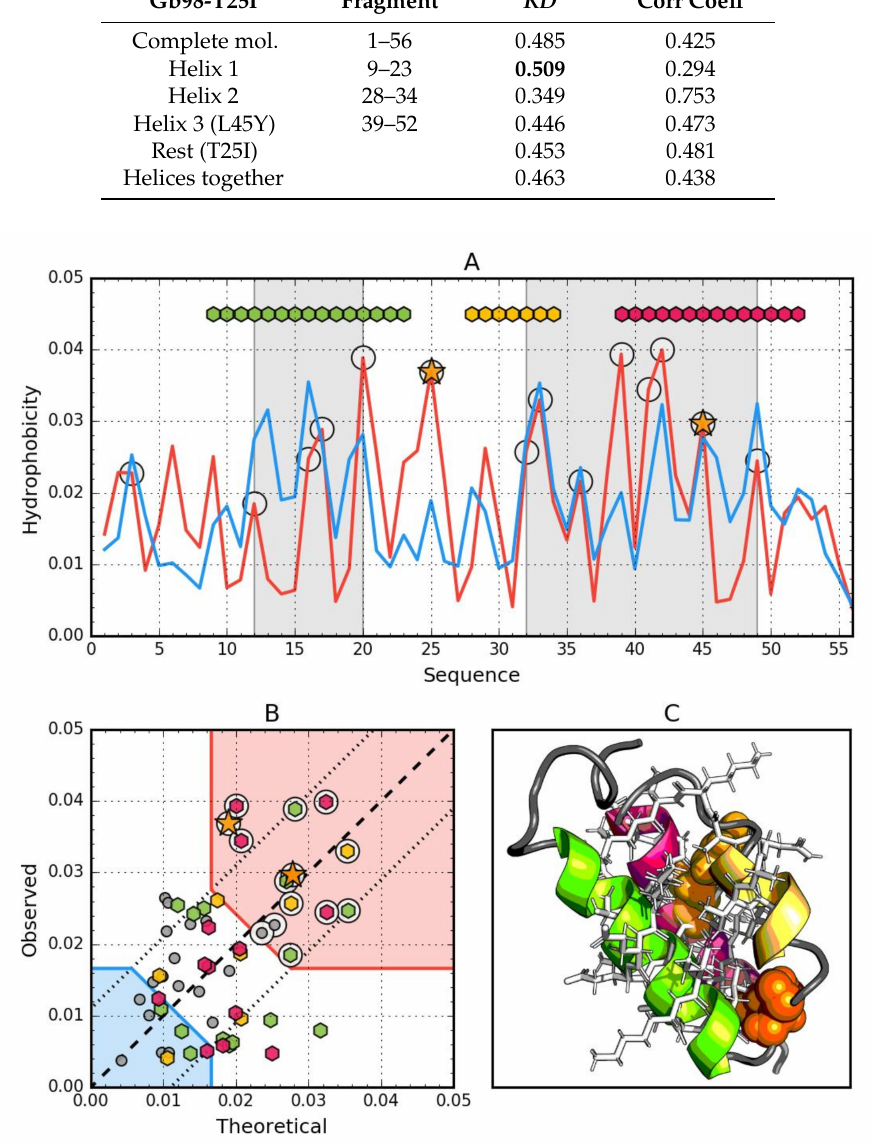
Figure 4. Hydrophobic properties of Gb98-T25I (2LHG). ( A ) theoretical—blue and observed— red hydrophobicity density profiles. Markers at the top denote individually colored elements of the secondary structure: Hexagons— α -helices, squares— β -strands. White circles mark the location of hydrophobic core as determined by the FOD model. Gray-shaded regions encompass contiguous sequence fragments containing this core. Orange stars locate the mutations (T25I, L45Y). ( B ) theoretical and observed hydrophobicity density scatter plot. Red shade—hydrophobic core zone, blue shade—hydrophilic surface zone. Markers denote the same residues as markers on A, except for small dark gray circles which are hydrophobicity parameters of unstructured fragments. Dashed line—theoretical and observed value equality line. Dotted lines—theoretical and observed value similarity threshold. ( C ) 3D presentation of the molecule. Secondary structures are distinguished using the same colors as on A. Hydrophobic core fragments are shown as white sticks, while mutations as orange